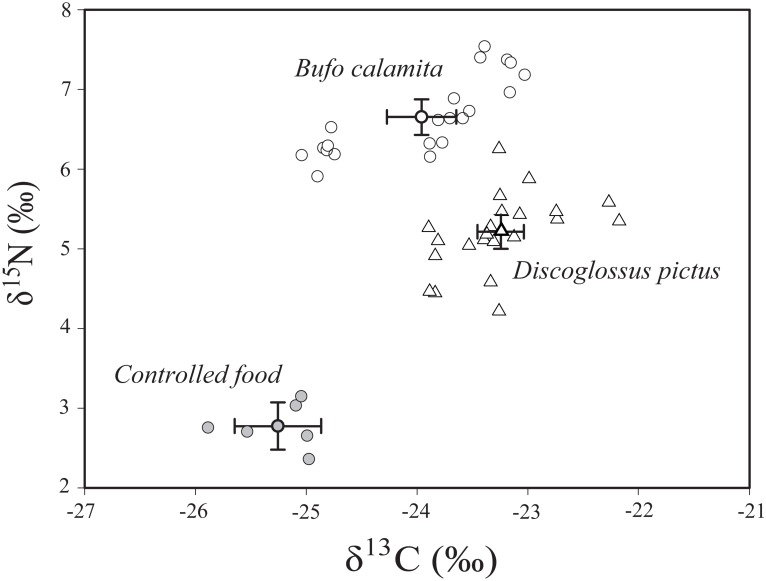
Mean and standard deviation of δ13C and δ15N values for B. calamita (filled circles; n = 21), D. pictus (empty circles) and the controlled diet (filled triangles; n = 21).